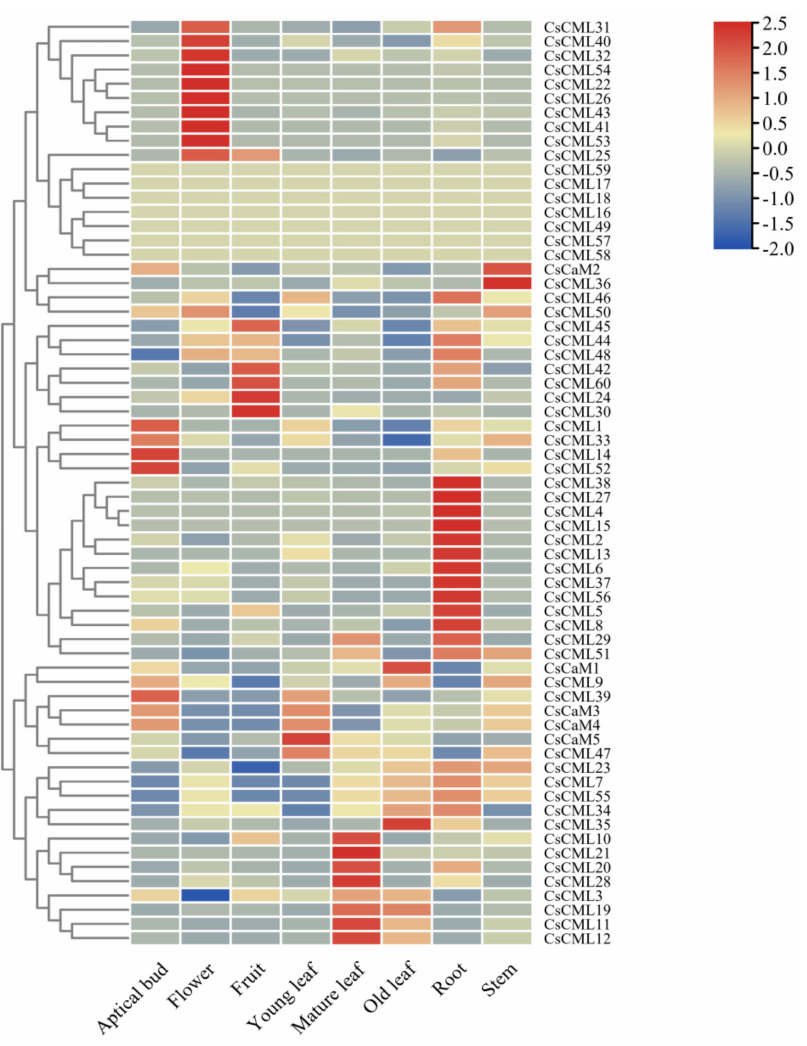
Figure 7. Expression profiles of CsCaM and CsCML genes in different tissues of the tea plant. Differential expression patterns of CsCaM and CsCML genes in root, flower, stem, terminal bud, young leaf, fruit, mature leaf, and old leaf of the tea